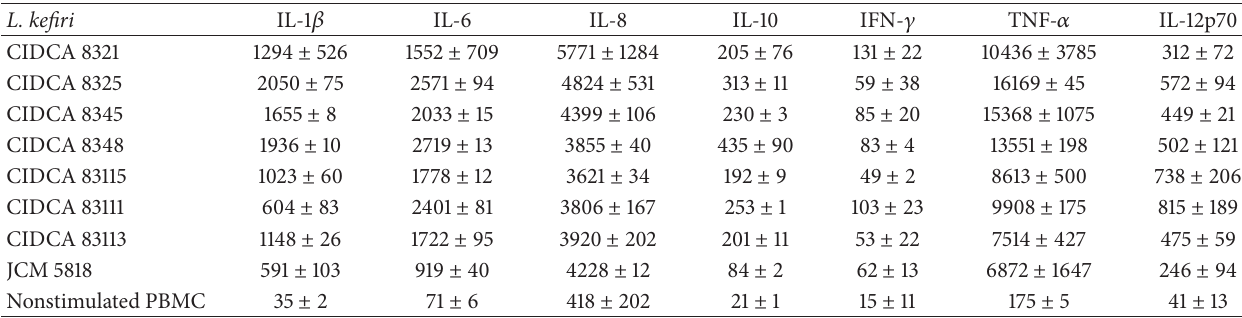
Table 2: Cytokine production after exposing PMBCs for 24 h to L. kefiri strains. Cytokines concentrations in culture cell supernatant (pgmL − 1 ) were measured using Flow Human Th1/Th2 11plex FlowCytomix Kit (eBioscience). The results are expressed as mean ± SD of experiments performed with three different